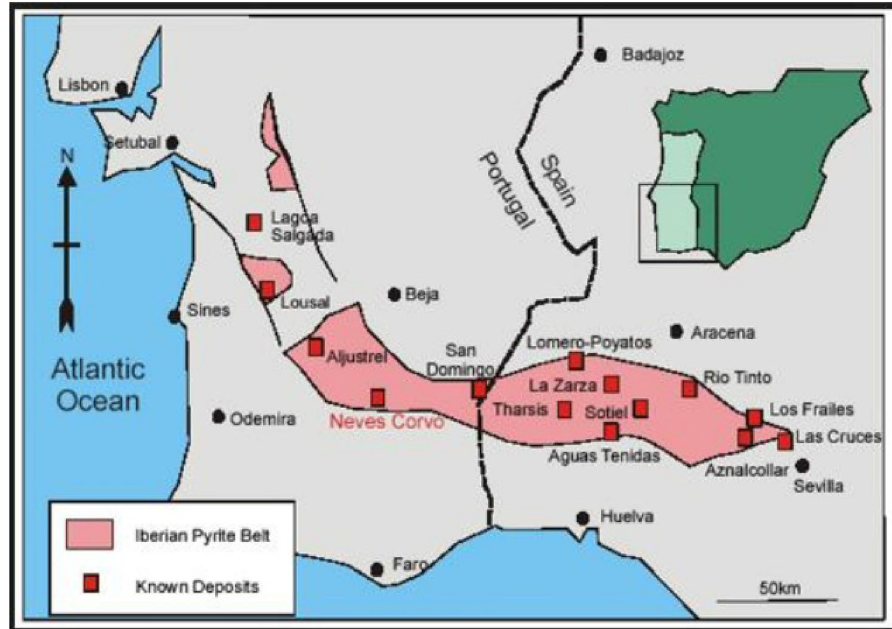
Fig. 1 Iberian pyrite